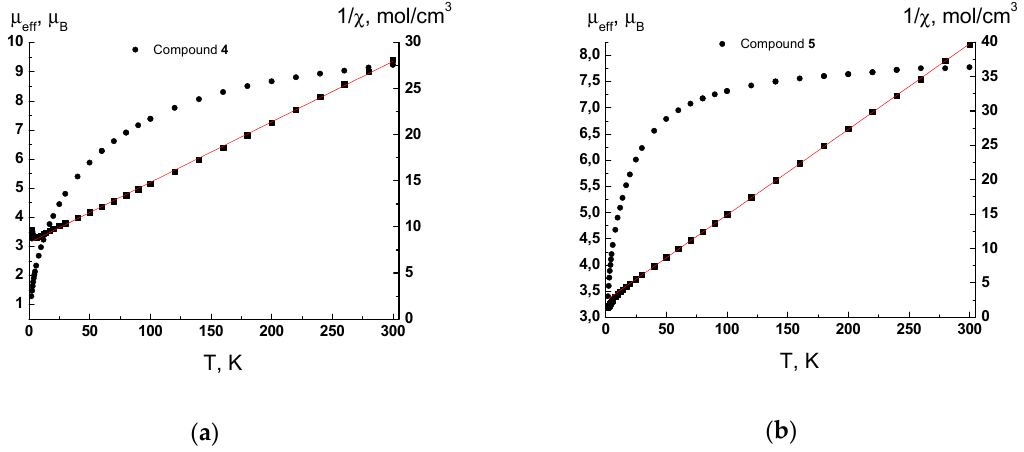
Figure 6. Temperature dependences of the µ eff ( ● ) and 1/ χ ( ■ ) for complexes 4 ( a ) and 5 ( b ). Solid lines are theoretical curves.